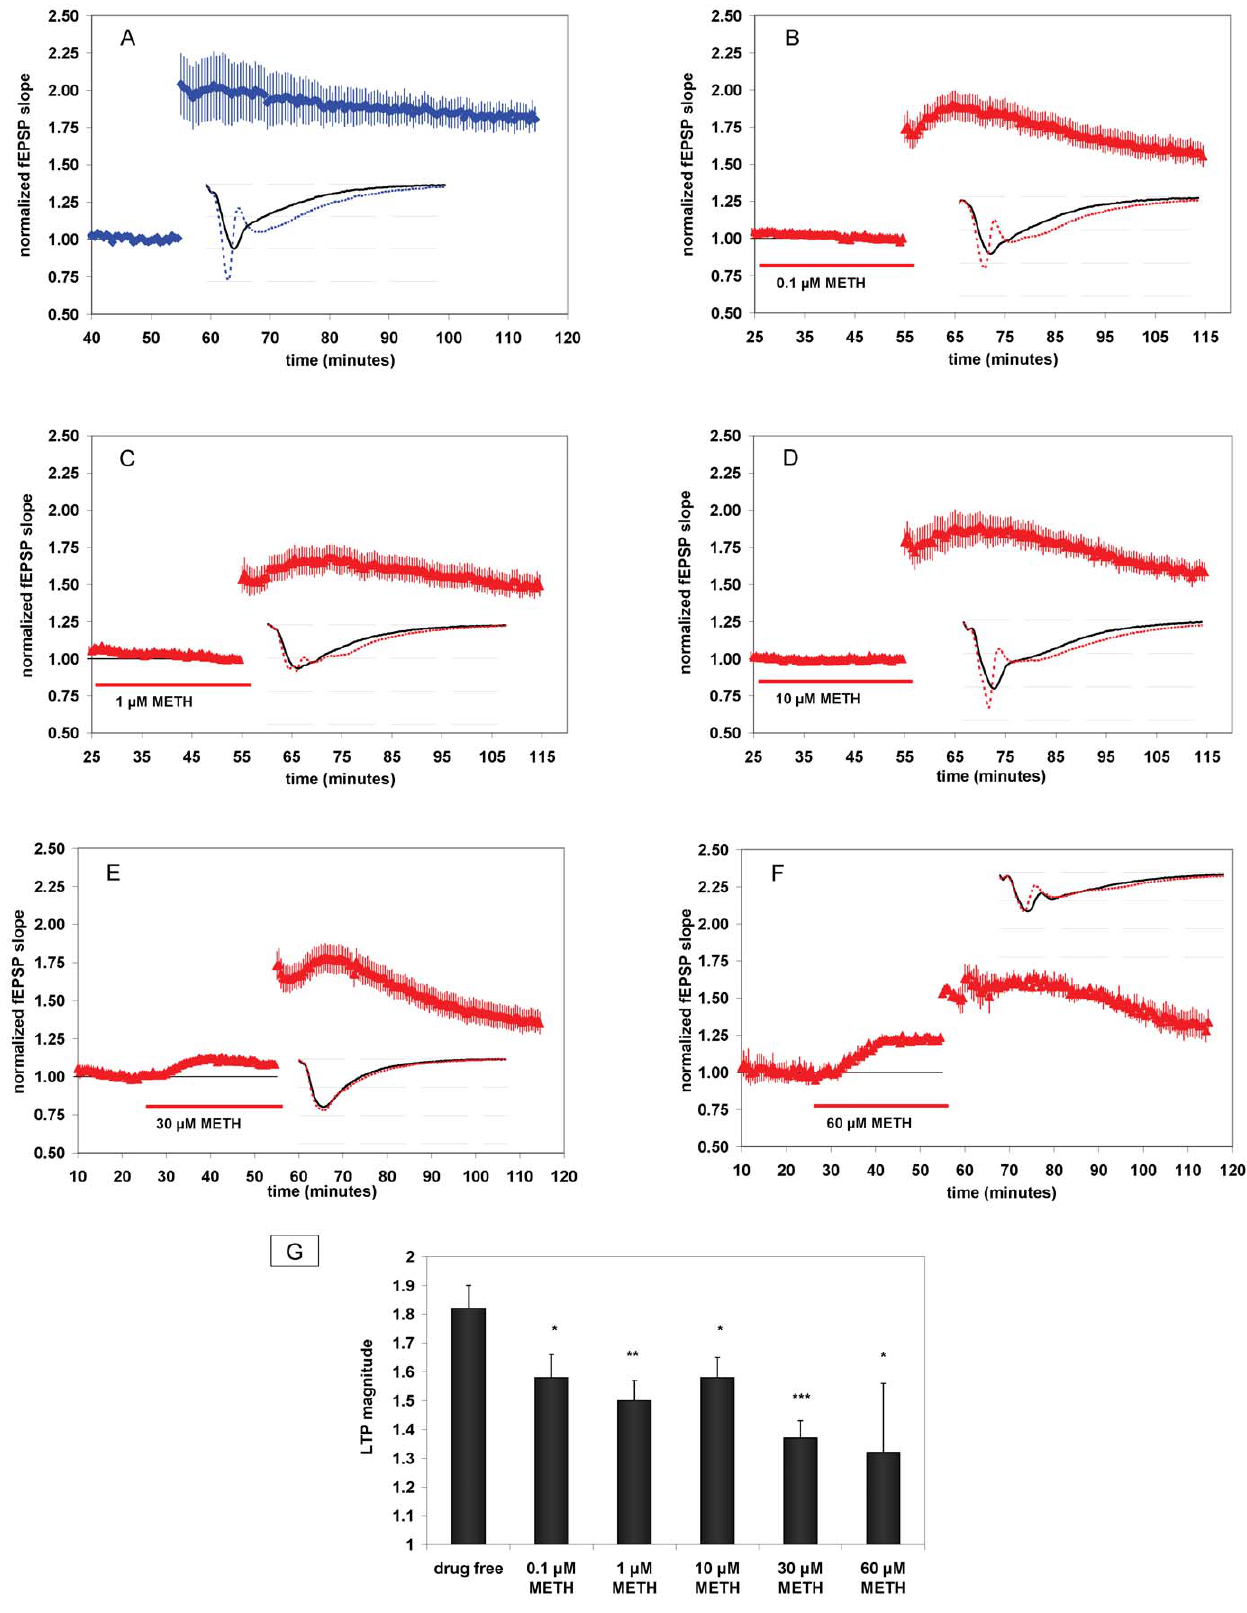
Figure 1. At lower concentrations, METH decreases LTP. At higher concentrations, METH increases baseline synaptic transmission and decreases LTP. ( A ) Summary plot of normalized fEPSP slope measurements recorded in the CA1 region of the hippocampus. Blue diamonds show results from drug free slices (A), red triangles (B–F) are from METH-treated slices. Error bars show 6 SEM. Insets are 30-msec sweeps taken from